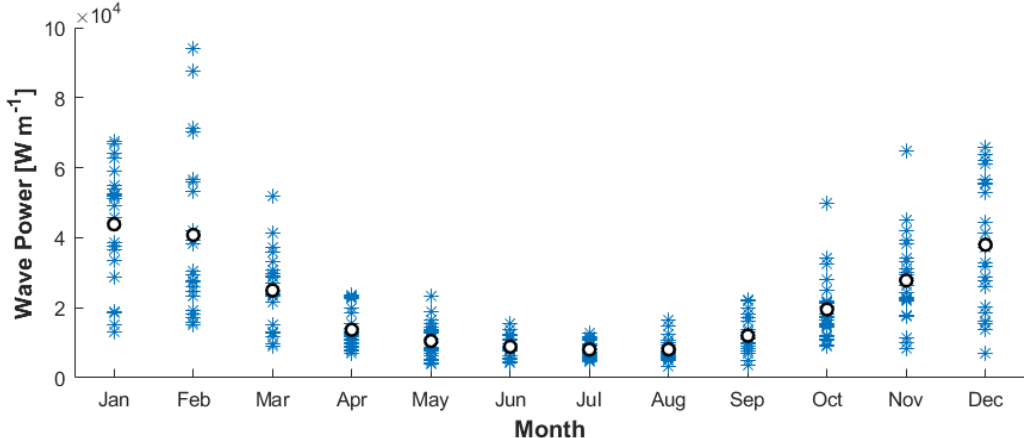
Figure 3. Illustrates the seasonal variations in mean wave power at Perranporth from 23 years of modelled data. The variability in the monthly means (blue stars) is considerably greater during winter months, when the overall mean wave power values (black circles) are higher as